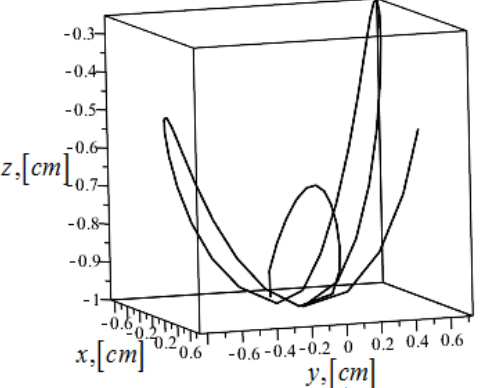
Figure 3. Trajectory of the moving ball in three-dimensional dimensions for the initial conditions: . . α ( 0 ) = π α ( 0 ) = − 10, ϕ ( 0 ) = 1, if the parameters are k 2 = γ = , ϕ ( 0 ) = π , 3 6